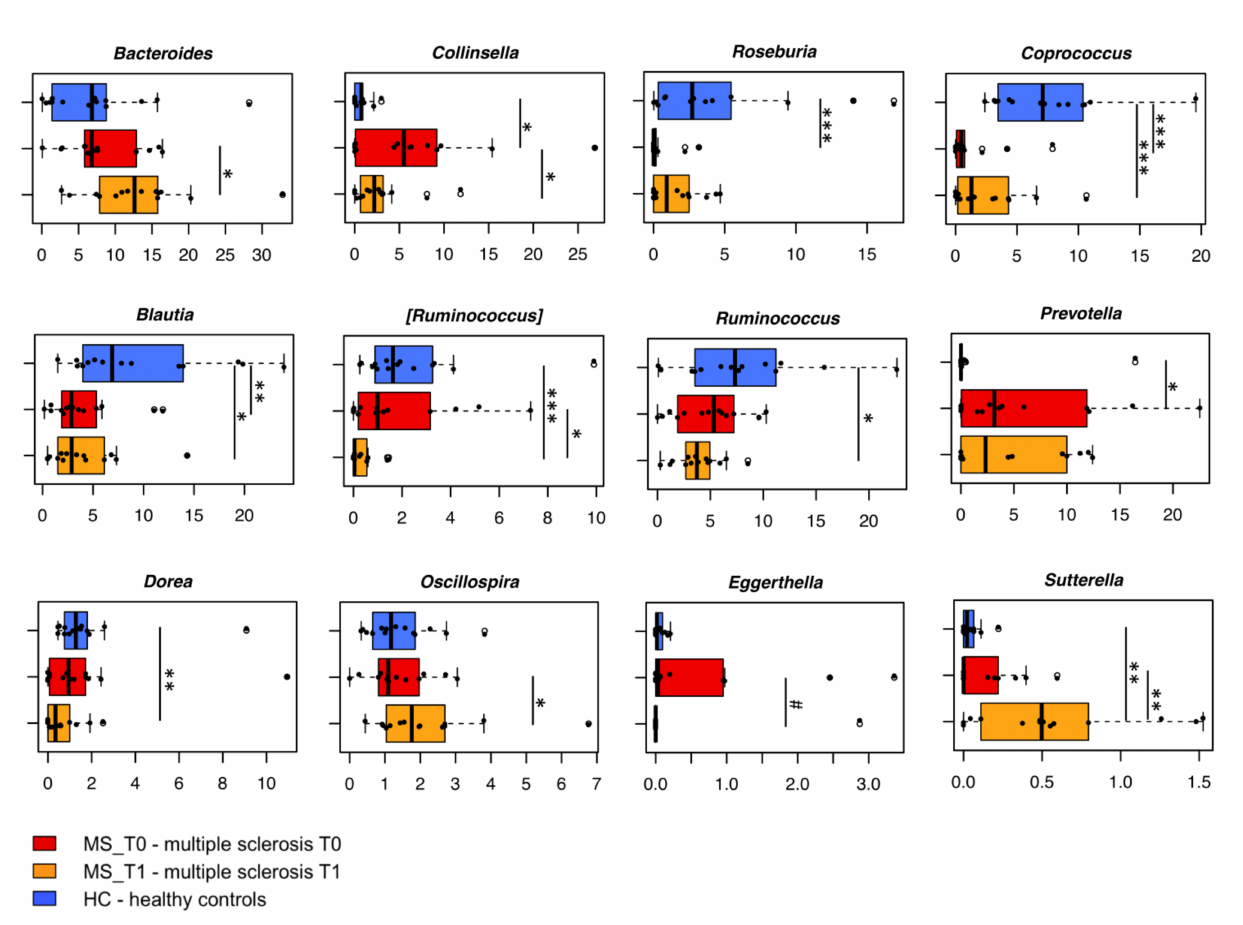
Figure 2. The dysbiotic layout of the gut microbiota in multiple sclerosis patients is partially recovered following the rehabilitation program. Boxplots showing the relative abundance distribution of bacterial genera significantly different between study groups (multiple sclerosis patients before (MS_T0, red) and after the rehabilitation program (MS_T1, orange), and age/sex-matched healthy subjects across Italy (HC, blue)). For Eggerthella , only a trend was observed. *, p ≤ 0.05; **, p ≤ 0.01; ***, p ≤ 0.001; #, p ≤ 0.1; Wilcoxon